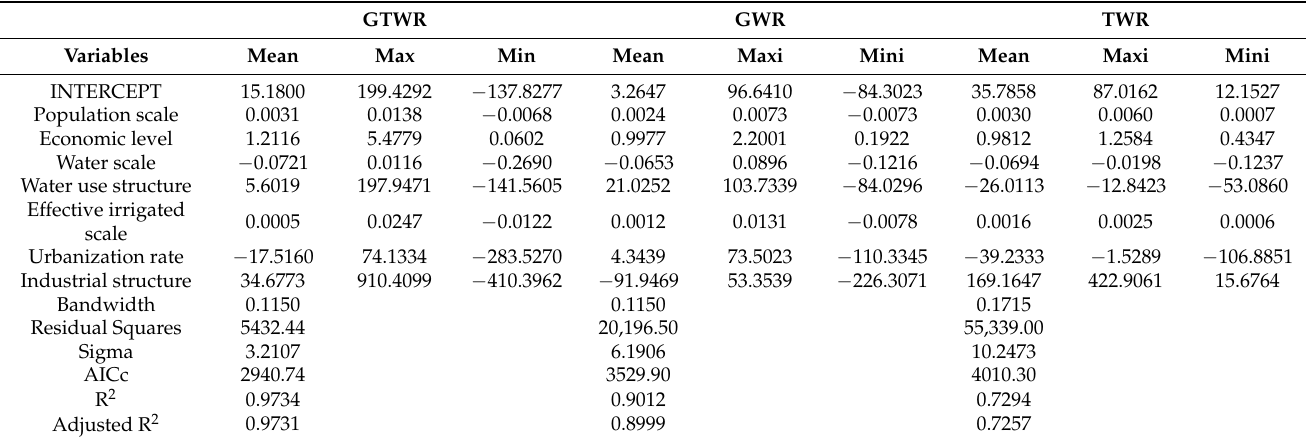
Table 4. Estimation results of GTWR, GWR, and